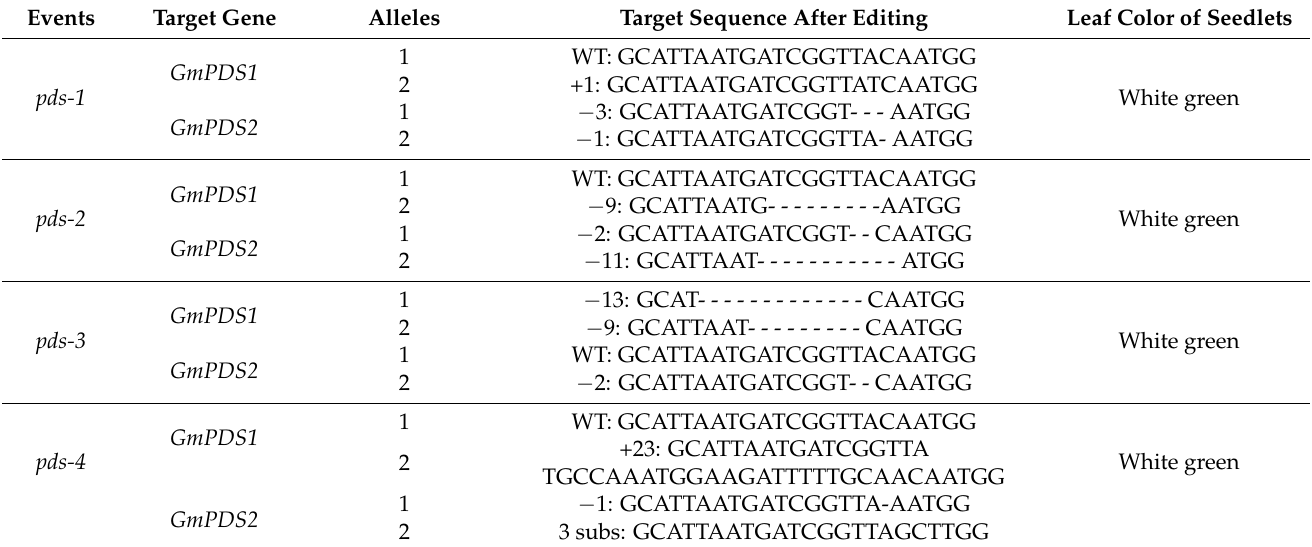
Table 2. Gene-editing patterns of the T 0 plantlets with mutations in both GmPDS1 and GmPDS2 .